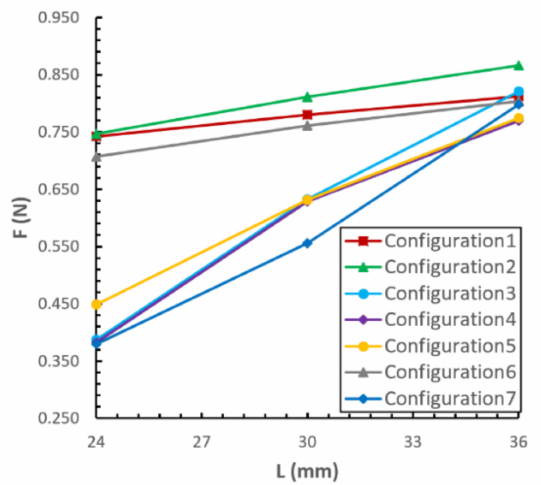
Figure 12. The influence of inlet configurations on suction force (quad-vortex array